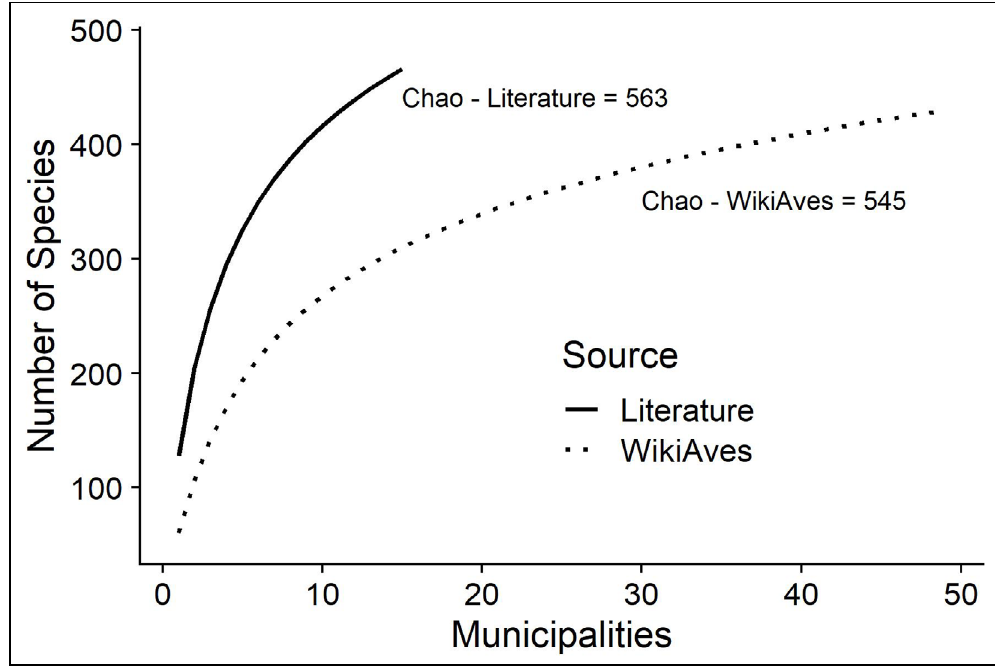
Figure 5 Species accumulation curves comparing the data from the literature ( solid line ) with WikiAves ( dotted line ). Note that species accumulated more rapidly and with more species in the literature. In WikiAves, the predicted value (Chao, 545 species) was less than the known value (558), whereas the literature predicted more species